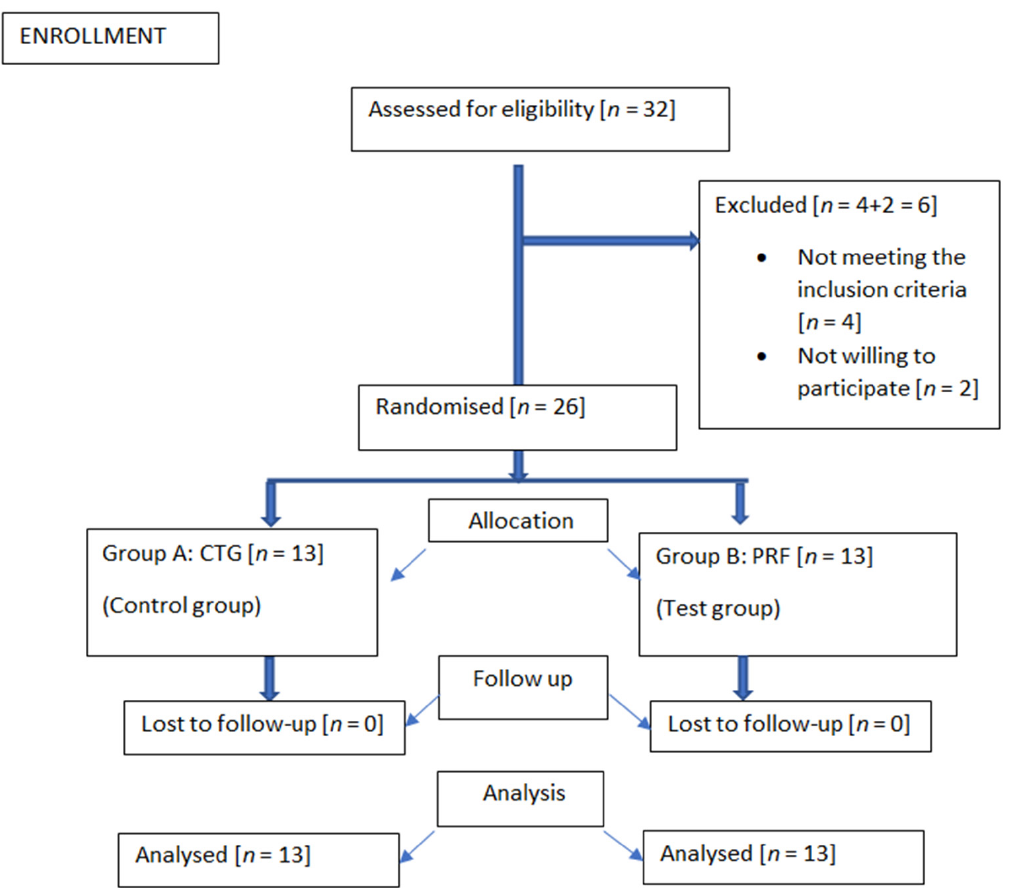
Figure 1. Consort Figure 1. Consort Diagram.